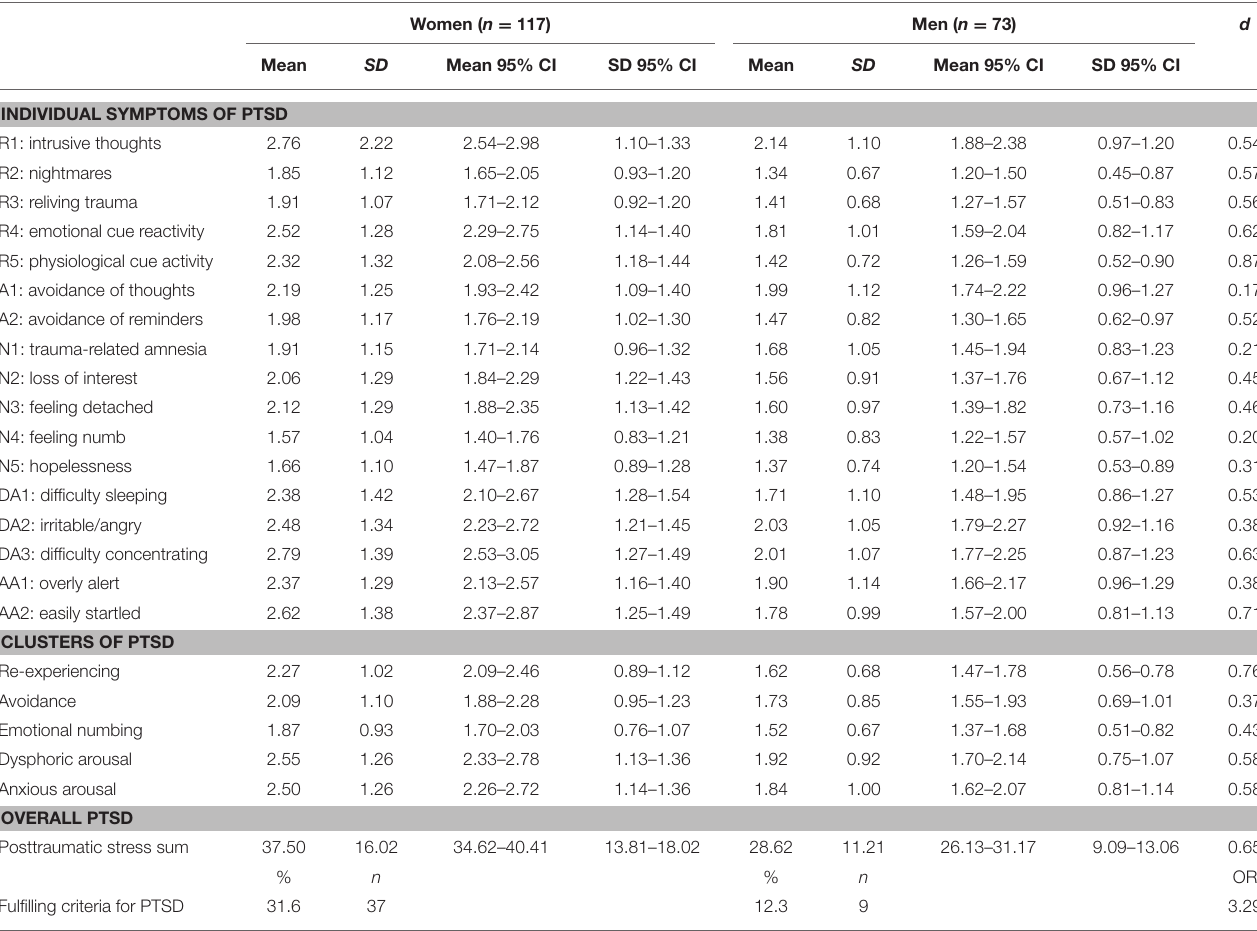
TABLE 2 | Distributions of posttraumatic symptom scores in directly exposed